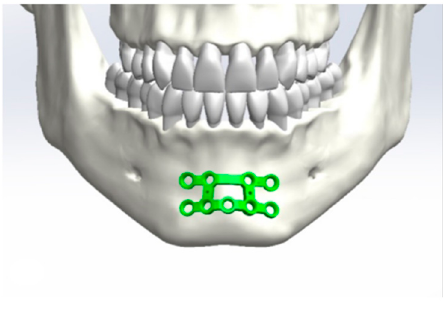
Figure 4. Positioning of the osteosynthesis plates in the area of the symphysis.